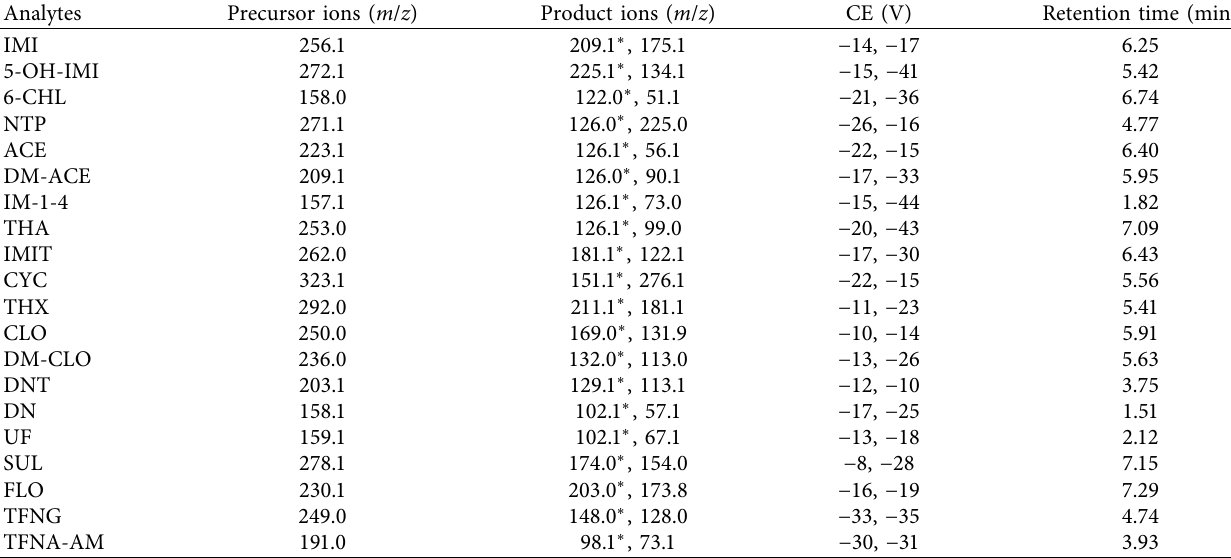
Table 1: Mass spectrometry parameters for the analysis of 20 neonicotinoids and their metabolites.